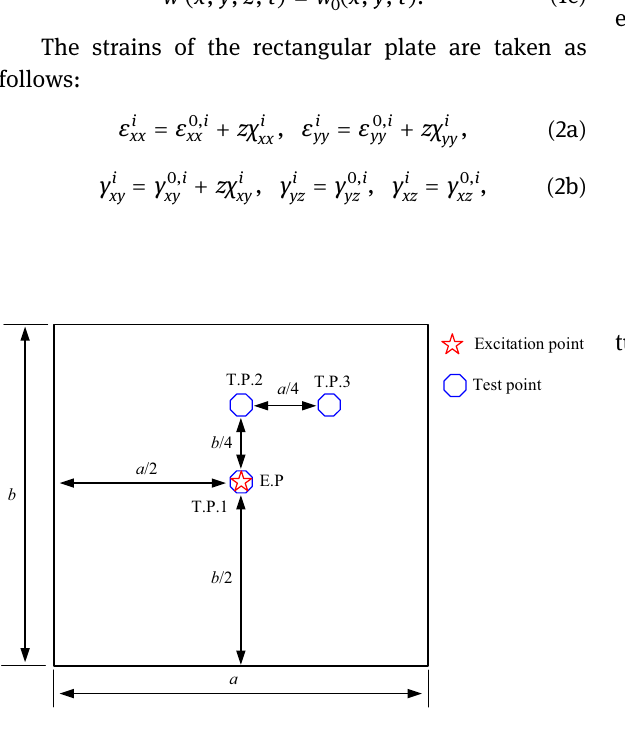
Figure 2: The excitation point and the examination point of the rectangular